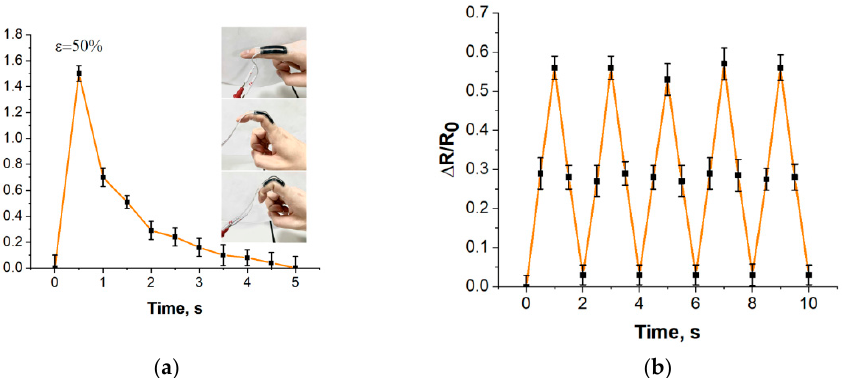
Figure 10. ( a ) Recovery time at 50% extension (insert—integration of the sensor with the finger joint); ( b ) response under cyclic loading during finger movement.